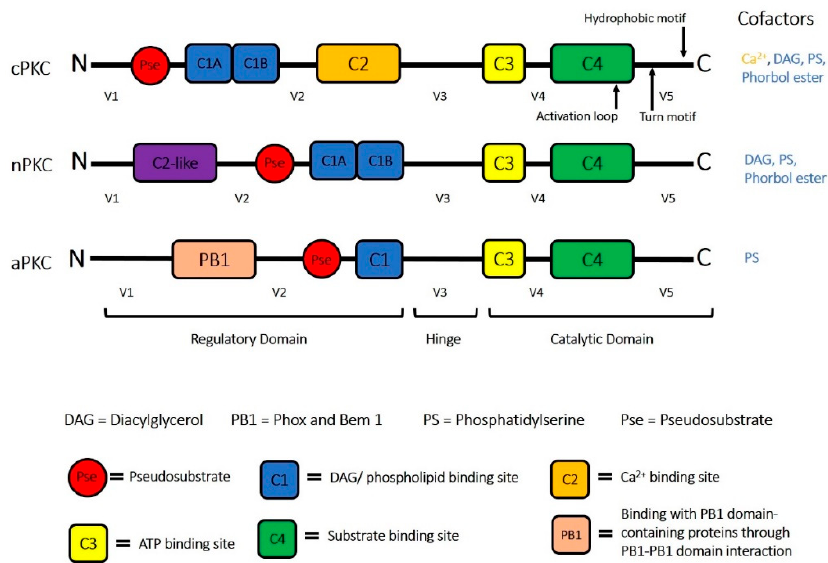
Figure 1. Structure of the three main classes of Protein Kinase C (PKC)s along with their respective activators. The hinge domain separates the regulatory domain and the catalytic domain. The regulatory domain contains: the pseudosubstrate (binds to C4 when not activated) for keeping the enzyme inactive; the C1 domain (including C1A and C1B) for DAG/PS/phorbol ester binding for cPKCs and nPKCs; the C2 domain for Ca 2+ binding; the C2-like domain for nPKC spatial distribution; and the C1 domain (in aPKCs) for PS binding. The catalytic domain contains the C3 domain for ATP binding and C4 domain for substrate/pseudosubstrate binding.